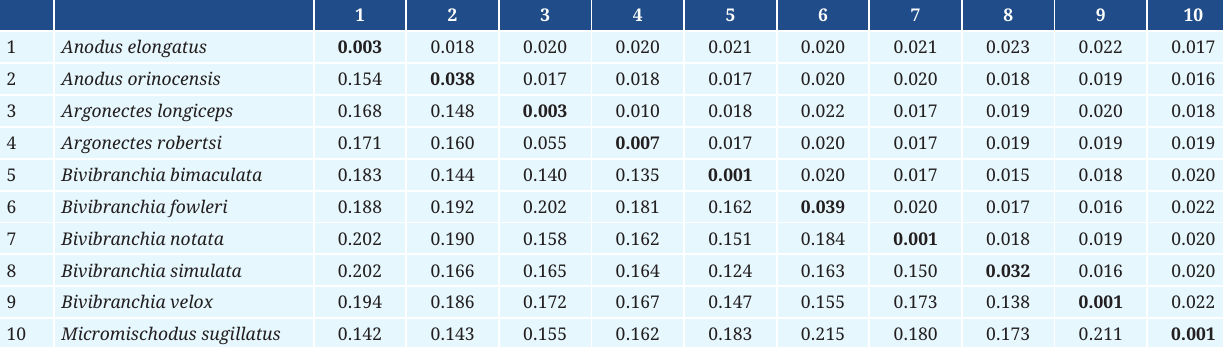
TABLE 2 | Matrix of pairwise TN93 genetic distance among species of Hemiodontidae with interspecific distances below the diagonal of bold numbers, the standard error estimates of interspecific distances above this diagonal and bold numbers representing intraspecific genetic